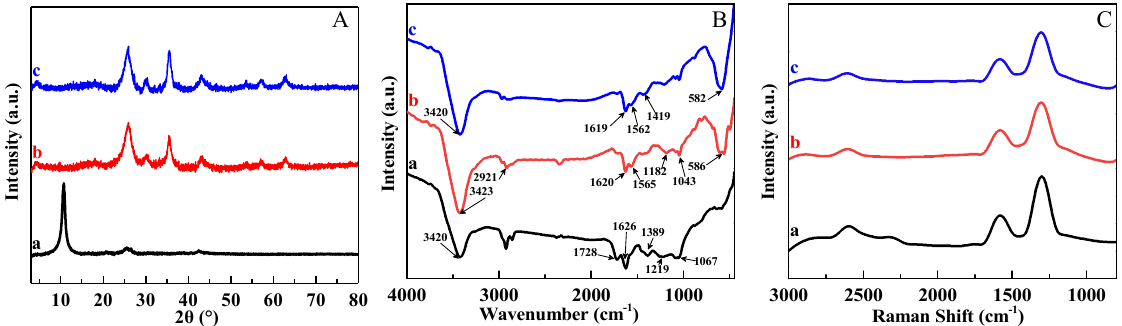
Figure 2. XRD patterns ( A ), FTIR spectra ( B ), and Raman analysis ( C ) of GO (a), MGO (b), and Figure 2. XRD pa tt erns ( A ), FTIR spectra ( B ), and Raman analysis ( C ) of GO ( a ), MGO ( b ), and GS − MGO (c) GS − MGO ( c ) nanohybrids.